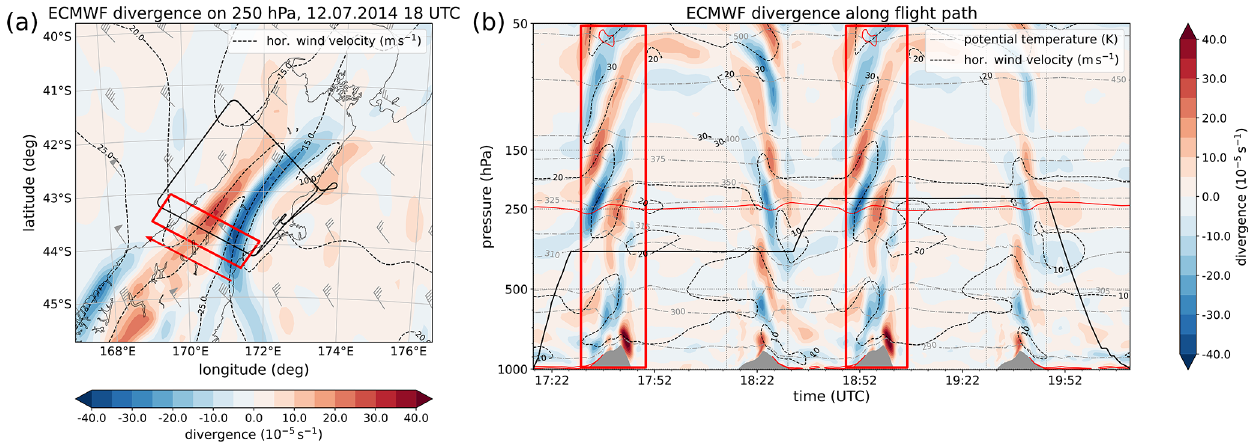
Figure 1. Divergence of the ECMWF horizontal wind during the time of flight (a) at 250hPa and (b) as vertical cross section along the flight track indicating the signature of gravity waves over the Southern Alps. The solid red line denotes the − 2PVU isoline and the solid black line denotes the flight track. The dashed black lines denote contours of the horizontal wind velocity (10, 15, 20, 25ms − 1 in (a) and 10, 20, 30ms − 1 in (b) ) and the dashed gray lines in (b) denote contours of potential temperature. Regions of interest are marked by red rectangles and the red arrow in (b) indicates the clockwise flight direction.